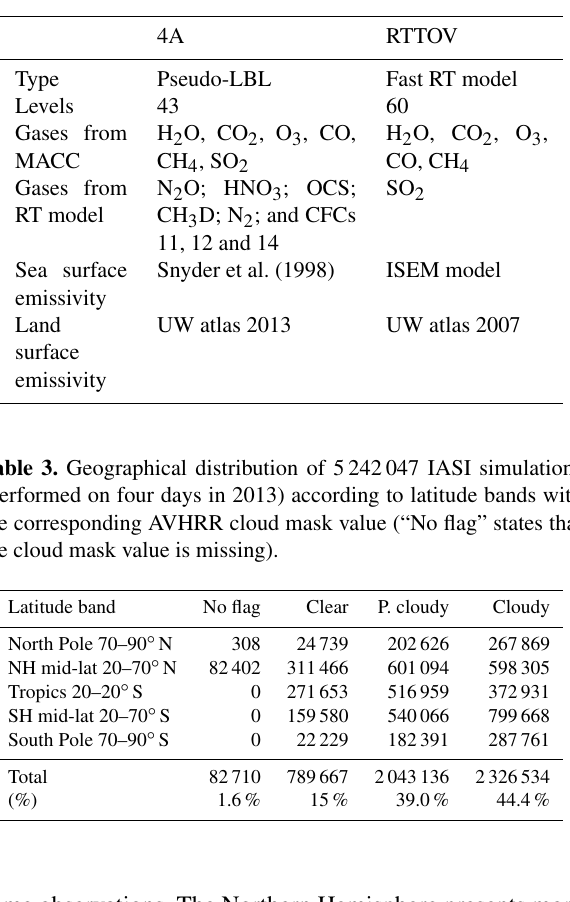
Table 2. Summary of the main differences between 4A and RTTOV radiative transfer (RT) model run configurations.